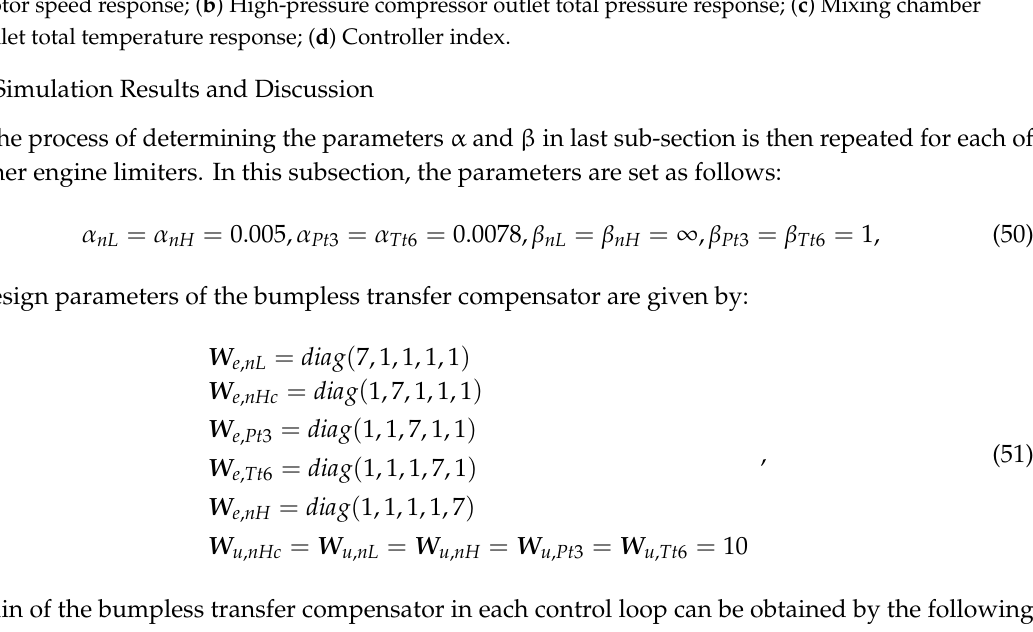
β : ( a ) Corrected 6 Tt